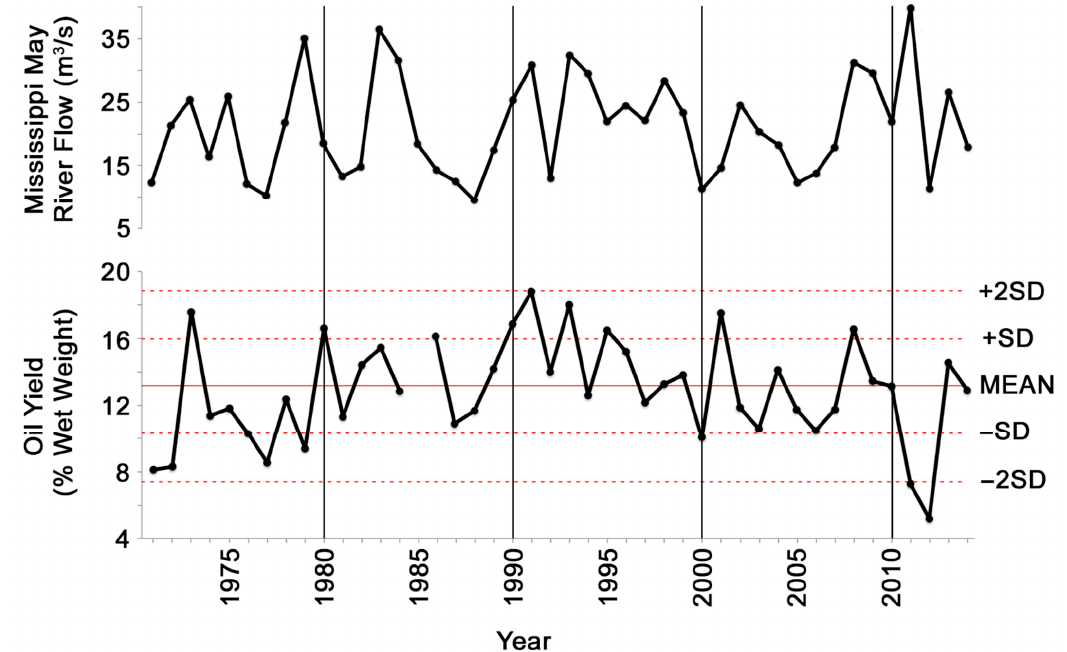
Figure 4. Comparison of Mississippi River discharge during May (upper panel) and the annual mean yield of fish oil, as % of wet fish weight for Gulf menhaden processed at Daybrook Fisheries, Inc. reduction plant at Empire, LA, 1971 to 2014.